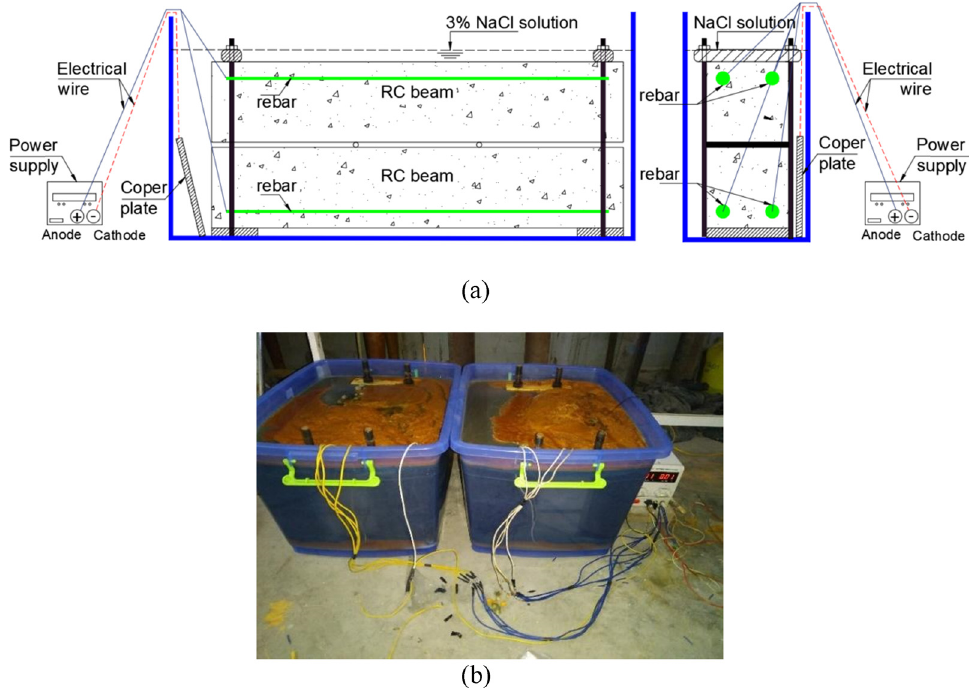
Figure 7: Soak beam in NaCl solution: ( a ) diagram description of accelerated corrosion test and ( b ) setup for accelerated corrosion test.